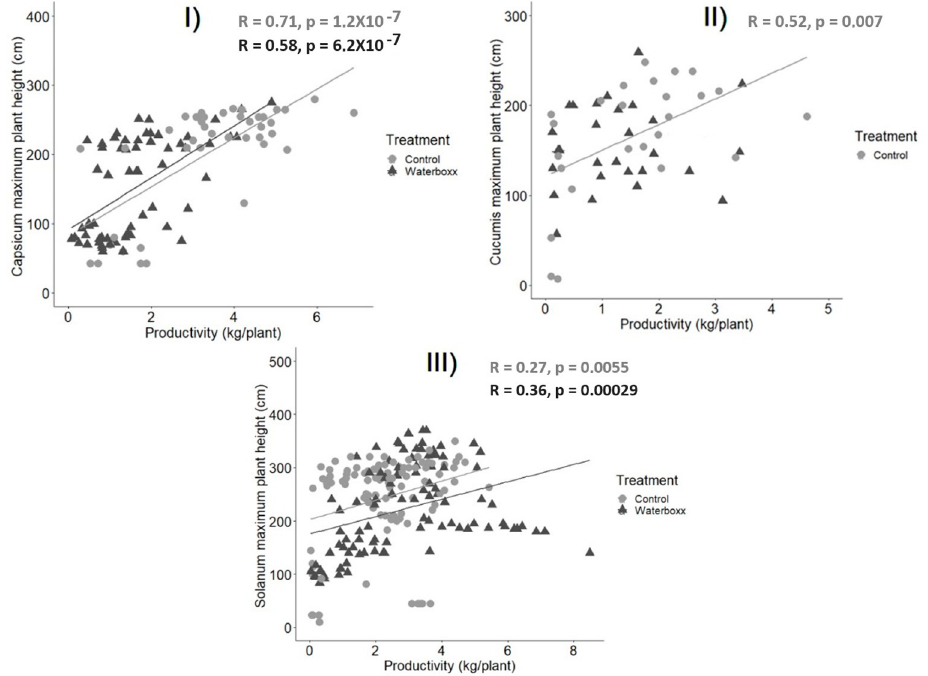
Figure 5. Pearson correlation between maximum plant height reached by the plant in cm and total productivity in kg comparing both treatments: Groasis Waterboxx ® and control. ( I ) Capsicum , ( II ) Cucumis , ( III ) Solanum. The data of Cucumis and Solanum are merged between both Islands (Santa Cruz and Floreana). Only significative values are shown.